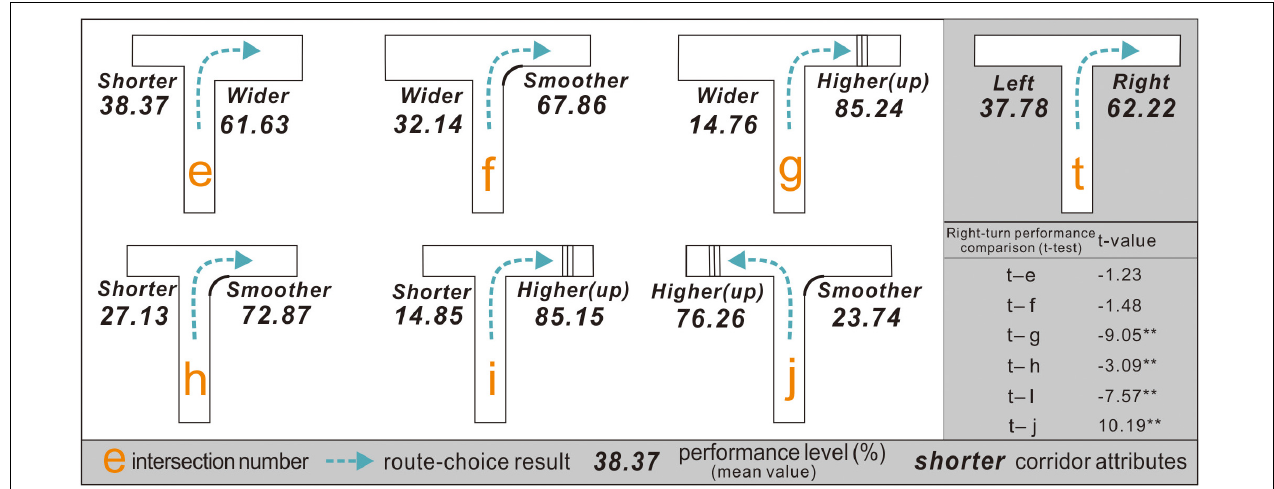
FIGURE 9 | Right-turn performance of exit-finders at intersections g – j demonstrates differences from that at intersection t but not for intersections e and f